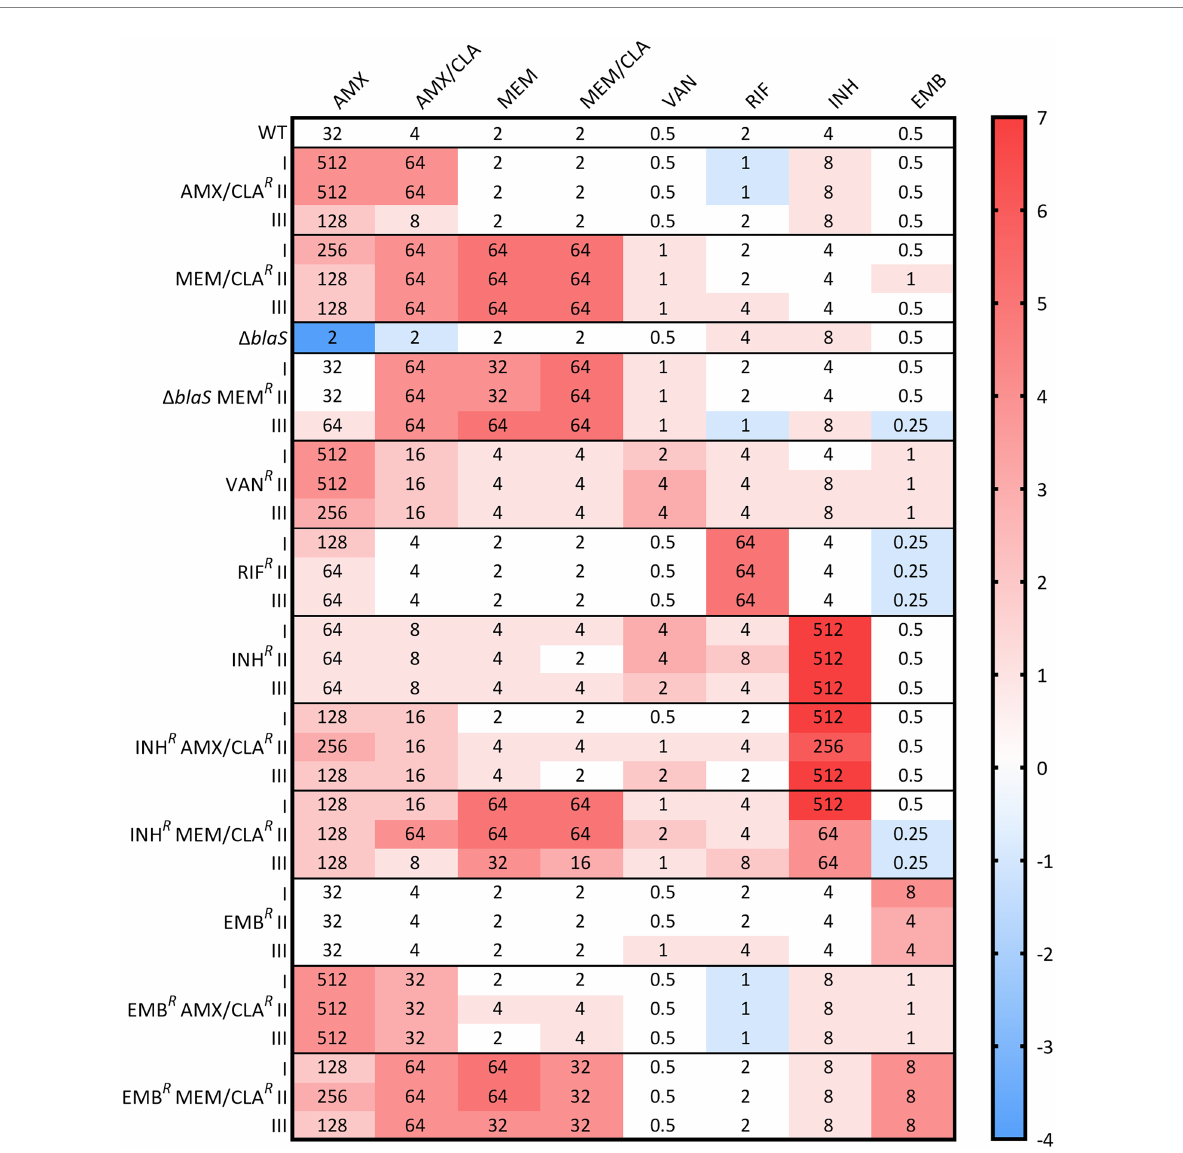
FIGURE 1 Heatmap of the log 2 fold changes in liquid medium minimum inhibitory concentrations (MICs) of the resistant Msm mc 2 -155 isolates. Columns represent the antibiotics and rows represent the isolates. The median MIC in mg/L of each antibiotic for each isolate is shown in the respective intersection and colors depict an increase (red/pink shades) or decrease (blue shades) in the value when compared to the wild type (WT) MICs. Δ blaS corresponds to the PM965 strain and its derivatives. AMX, amoxicillin; CLA, clavulanate; EMB, ethambutol; INH, isoniazid; MEM, meropenem; RIF, rifampicin; VAN,